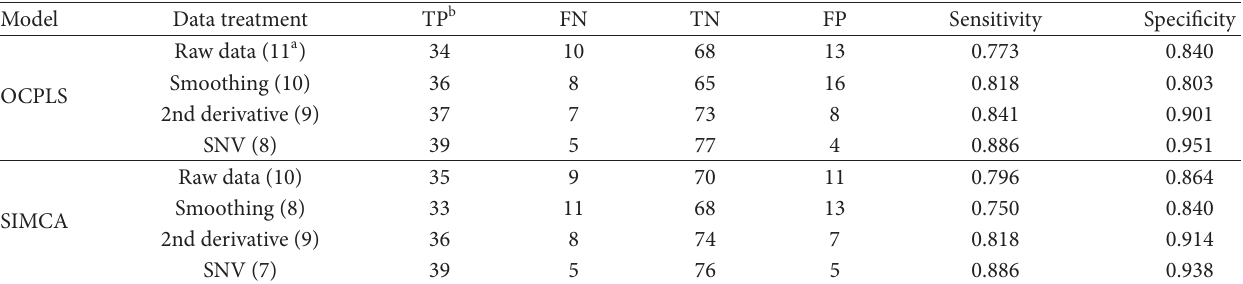
T 2: Predicting results obtained by OCPLS and